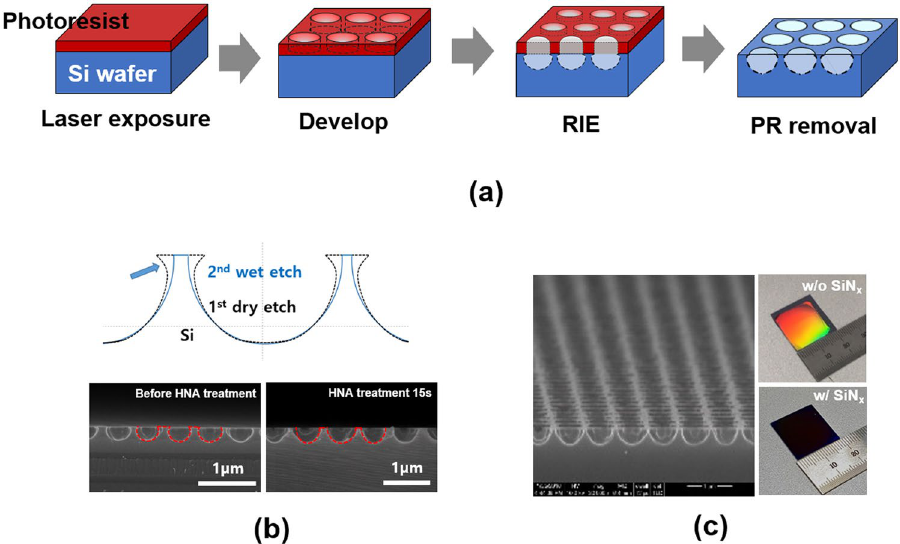
Figure 5. ( a ) Illustrations of a nanohole arrays fabrication process. Photoresist is spun on Si wafers, nanohole arrays are developed by laser interference lithography, Si nanohole arrays are formed by a SF 6 RIE process, and photoresist is removed. ( b ) Schematic of Si nanoholes in cross-sectional view with a two-step etch process to remove undercut. Cross-sectional SEM images of Si nanohole arrays before and after HNA treatment (bottom left, bottom right). ( c ) Tilted view image of Si nanohole arrays after HNA treatment. Photograph images of Si nanhole arrays without and with SiNx deposition (right).